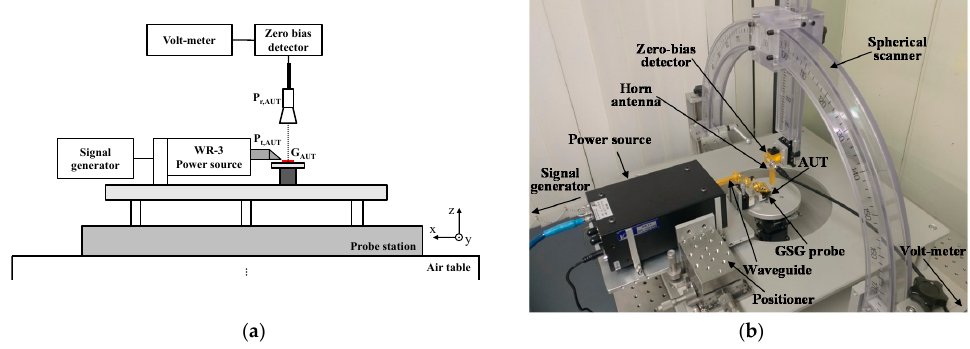
Figure 11. THz on-chip antenna measurement setup. ( a ) Diagram. ( b ) Photograph.